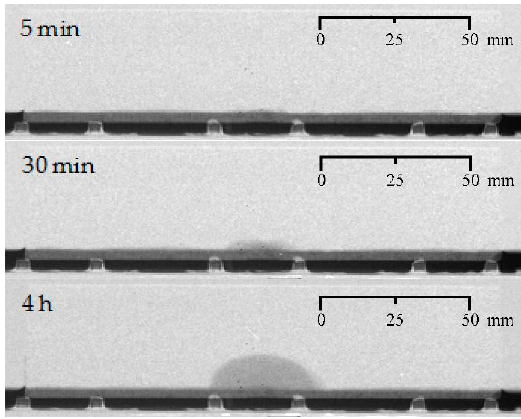
Figure 5. Visualization of the water uptake as a function of exposure time using neutron radiography for one uncracked mortar prism (representative sample: UN_A).